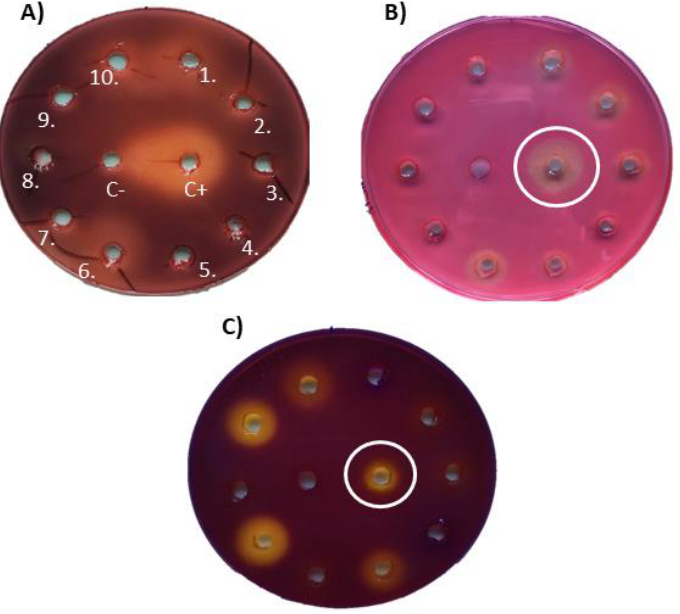
Figure 6. Example of enzymatic activity assays for ( A ) cellulases; ( B ) endoglucanases; ( C ) feruloyl esterases. 1–10: samples; positive control (C+): Penicillium rubens ; negative control (C-): sterile me- dium.